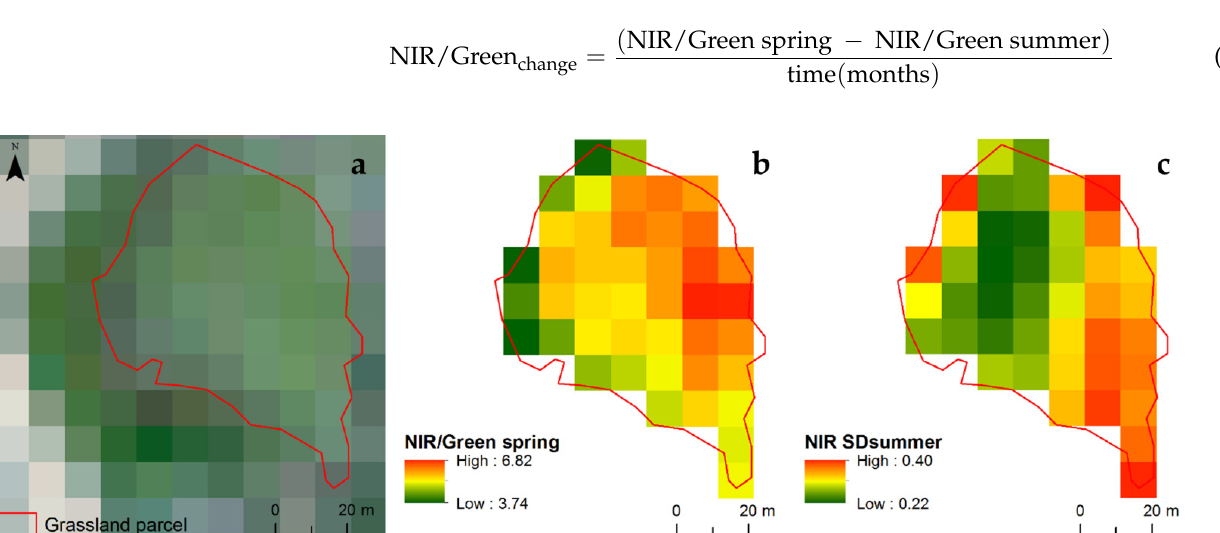
Figure 3. ( a – c ) Illustration of the features of predictors using the sampled parcel geometry, the NIR/Green ratio in the spring and the standard deviation of NIR band in the summer (NIR SD summer) in a sampled parcel.